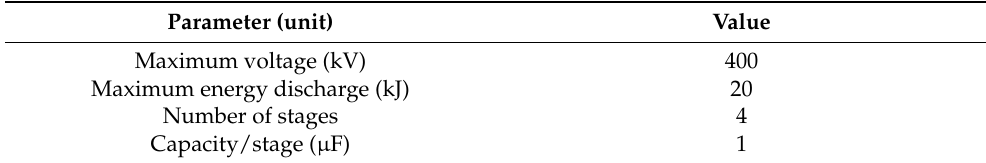
Table 3. General specifications of the HVEP